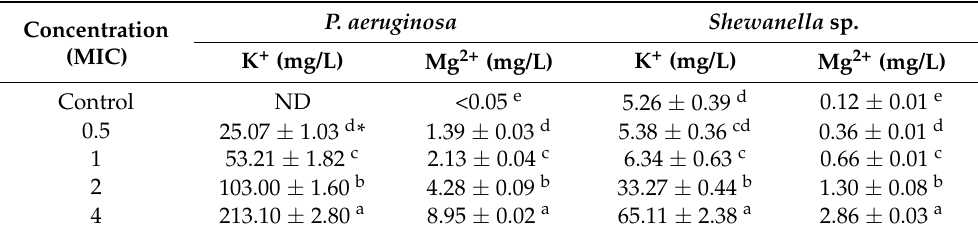
Table 4. Content of potassium (K + ) and magnesium (Mg 2+ ) ions released from P. aeruginosa and Shewanella sp. cells treated with CLE at varying